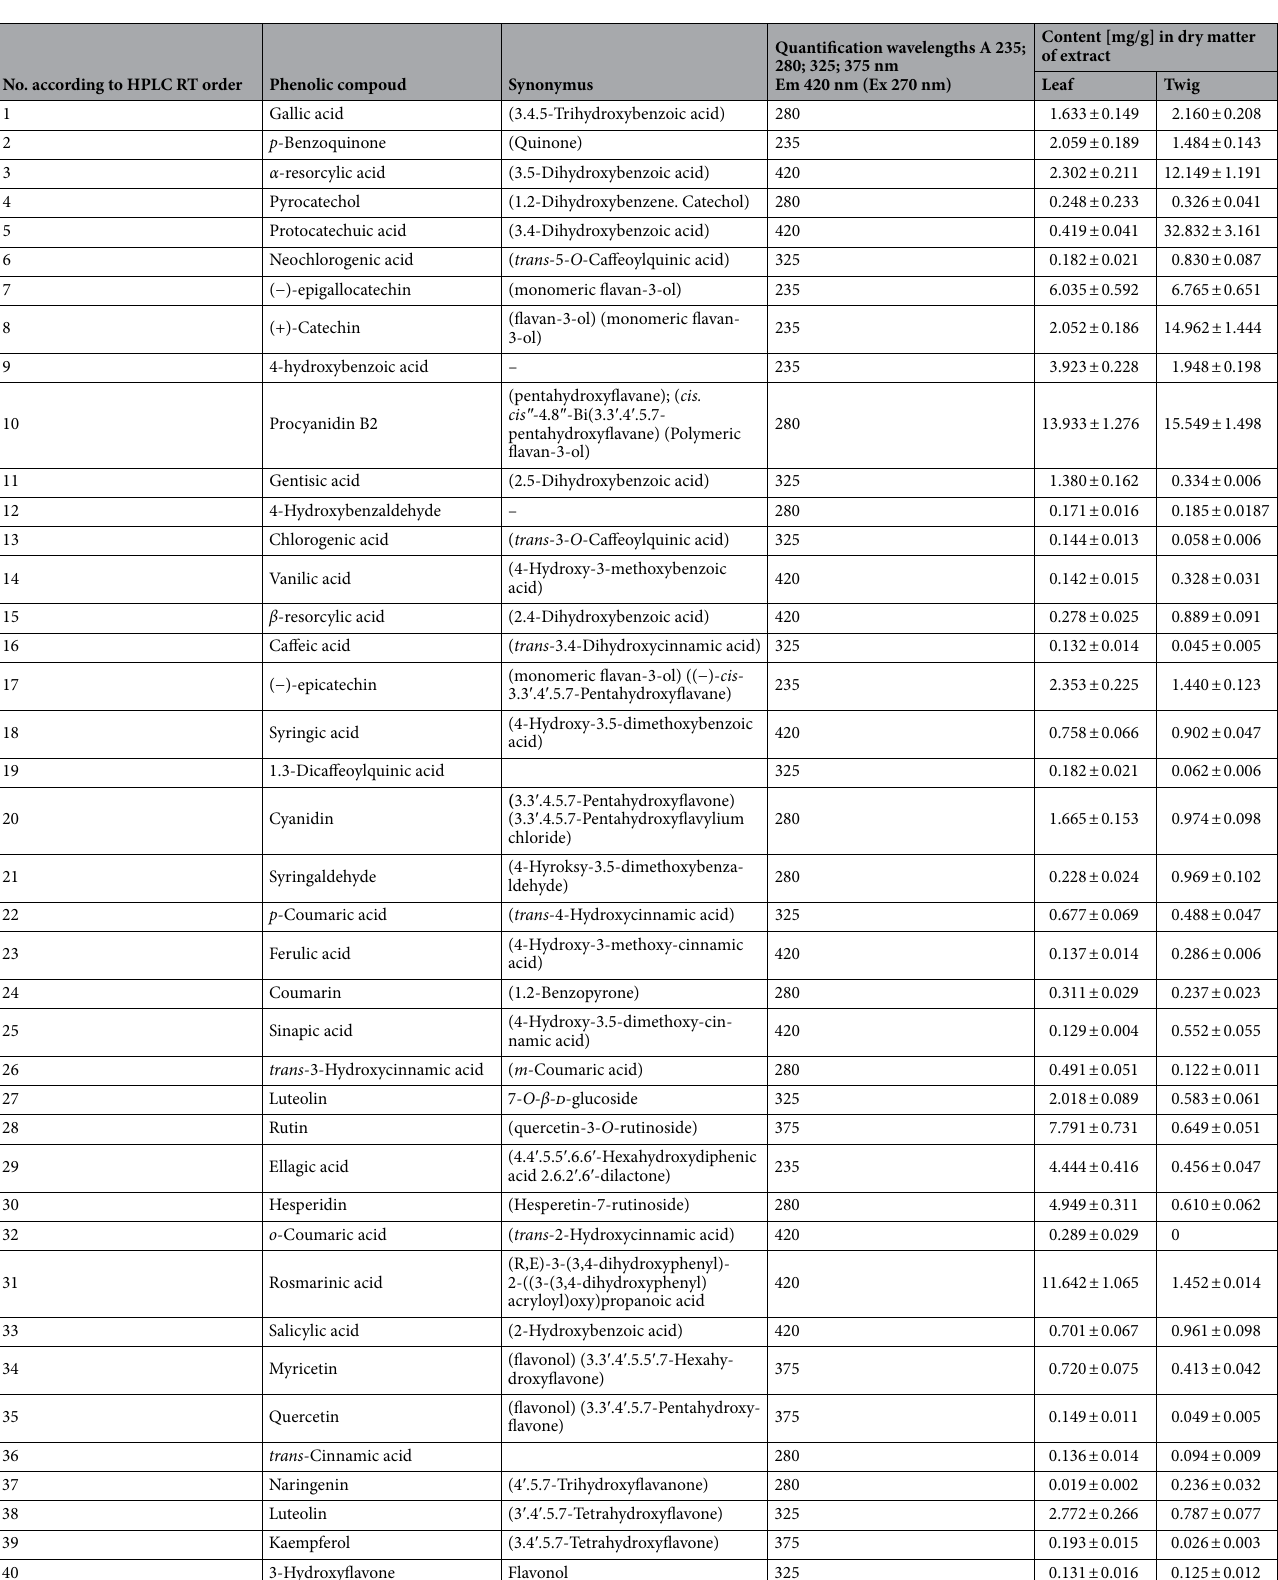
Table 1. Content of phenolic compounds detected using HPLC in the extracts of H. rhamnoides L. leaves and twigs. Values are means ± SD (n =